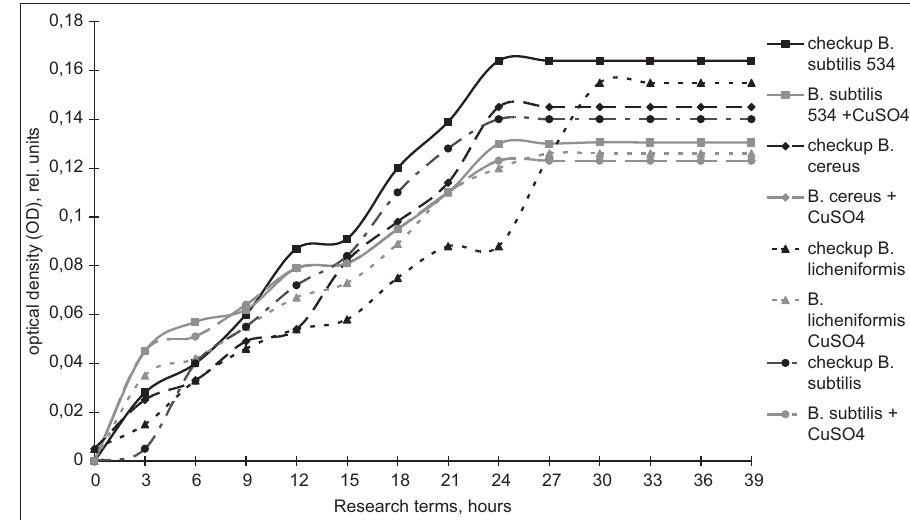
Figure-1: Evaluation of the impact of copper ions on the growth phases of the microorganisms.